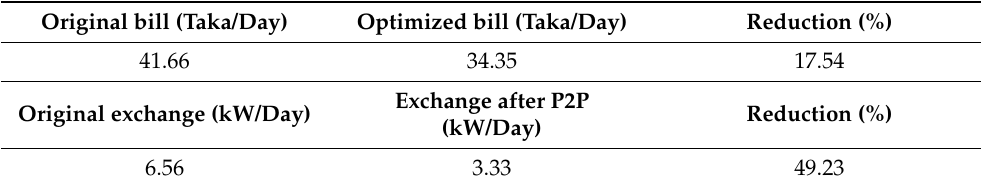
Figure 13. Difference of net power curves ( a ) PV prosumer ( b ) Wind turbine prosumer . Variation of the Inconvenience Factor α